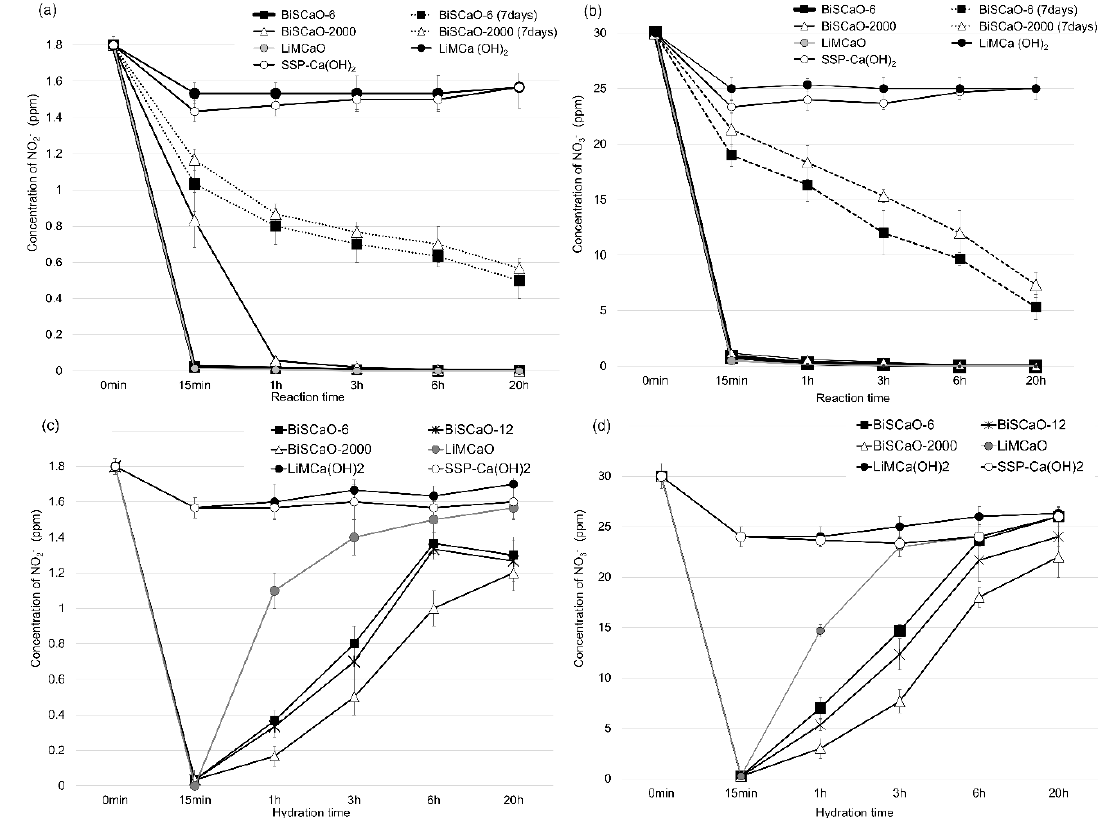
Figure 6. Decreasing NO 3 − and NO 2 − by BiSCaO, SSP-Ca(OH) 2 , LiMCaO, and LiMCa(OH) 2 . ( a , b ) The concentration of NO 3 − and NO 2 − at the indicated reaction times after adding 0.2 wt% BiSCaO-6, BiSCaO-2000 or LiMCaO powders to pure water containing 1.8 ppm NO 2 − and 30 ppm NO 3 − were measured. BiSCaO-6 (seven days) and BiSCaO-2000 (seven days) were incubated at 37 ◦ C in the absence of desiccant for seven days before adding to pure water containing NO 3 − and NO 2 − . ( c , d ) Each BiSCaO and LiMCaO powder was hydrated in pure water during several time periods, then added to pure water containing NO 3 − and NO 2 − . The mixture was incubated at room temperature for 1 h and the concentration of NO 3 − and NO 2 − was measured.